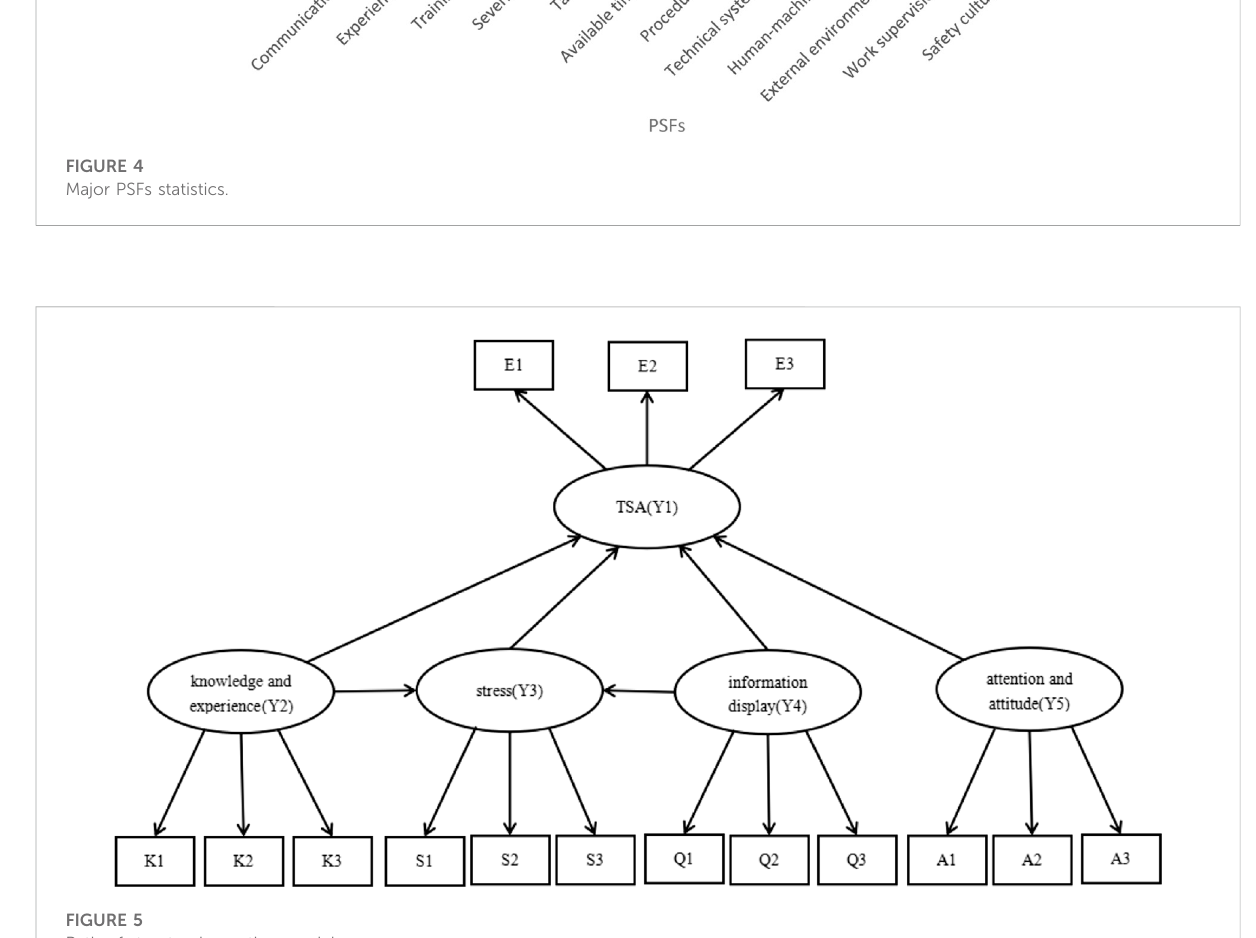
FIGURE 5 Path of structural equation